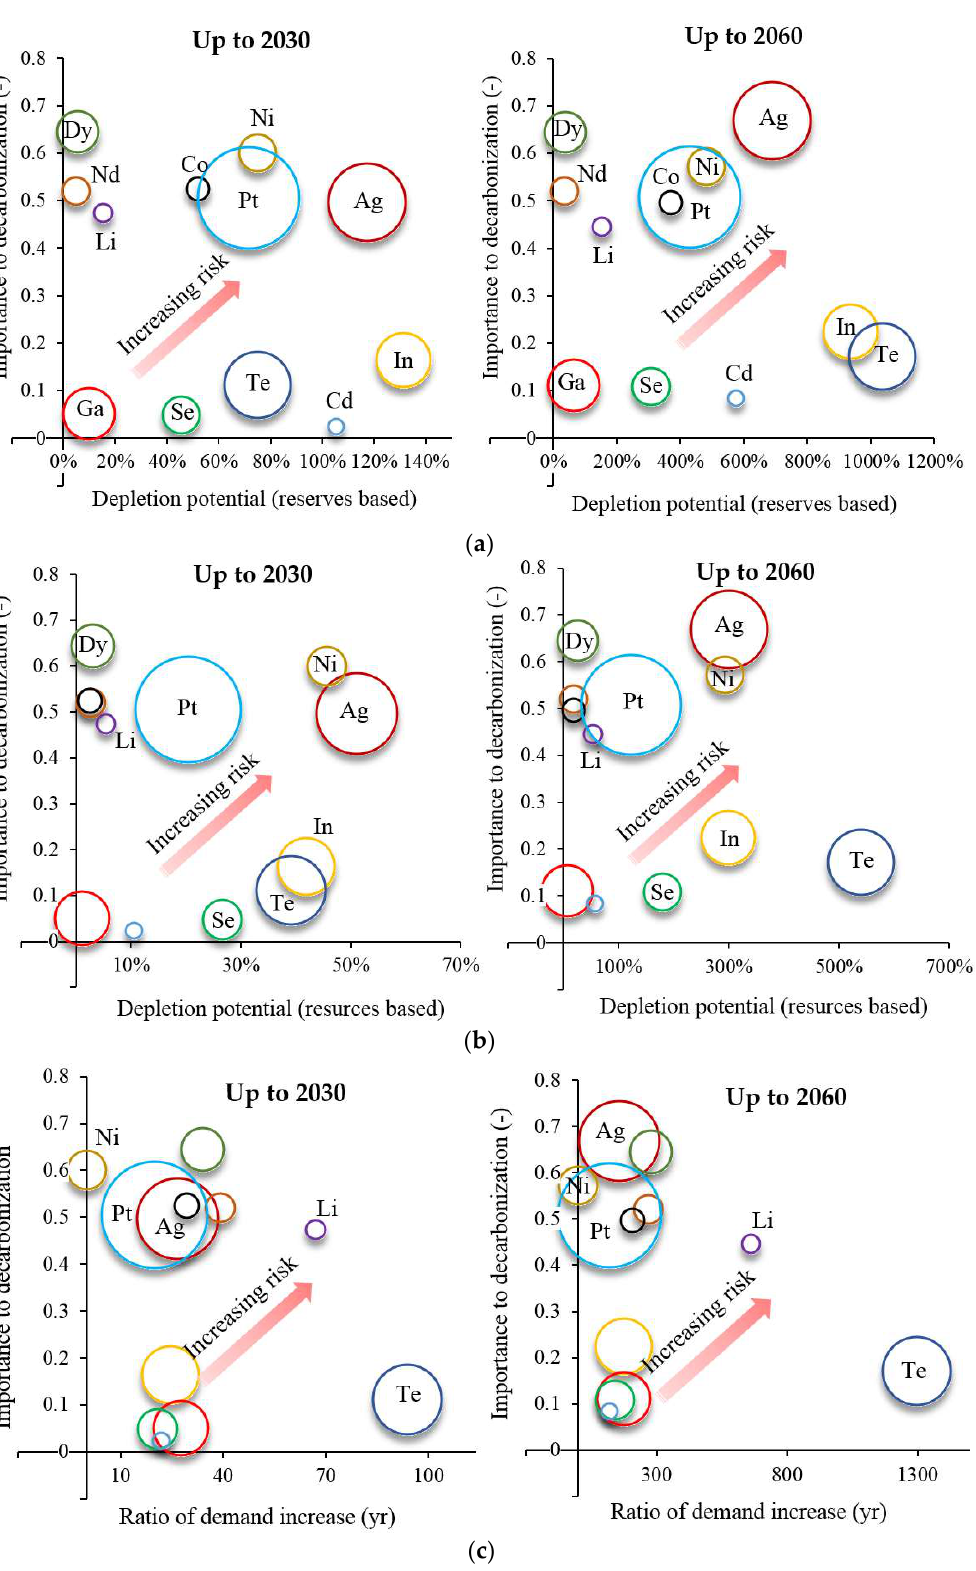
Figure 19. Criticality analysis results expressing the depletion potential or the ratio of demand increase on the horizontal axis and the importance for decarbonization on the vertical axis; bubble size expresses the size of the environmental impact. ( a ) The horizontal axis is the depletion potential (reserves based) ( b ) The horizontal axis is the depletion potential (resources based) ( c ) The horizontal axis is the ratio of demand increase.